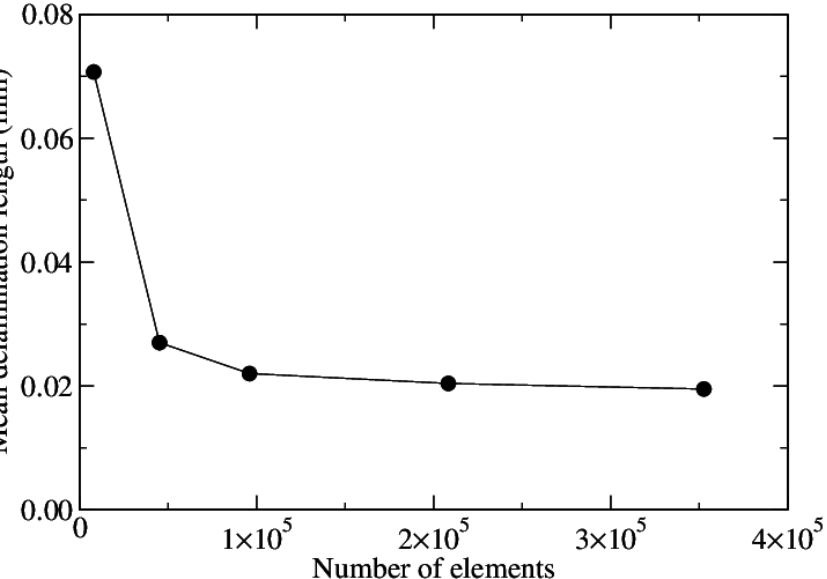
Figure 9. Mean delamination length as a function of the number of finite